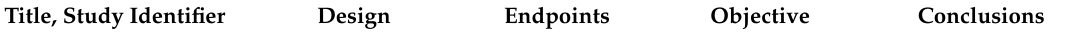
Reviewed studies examining the e ff ects of vitamin D supplementation on CAD and